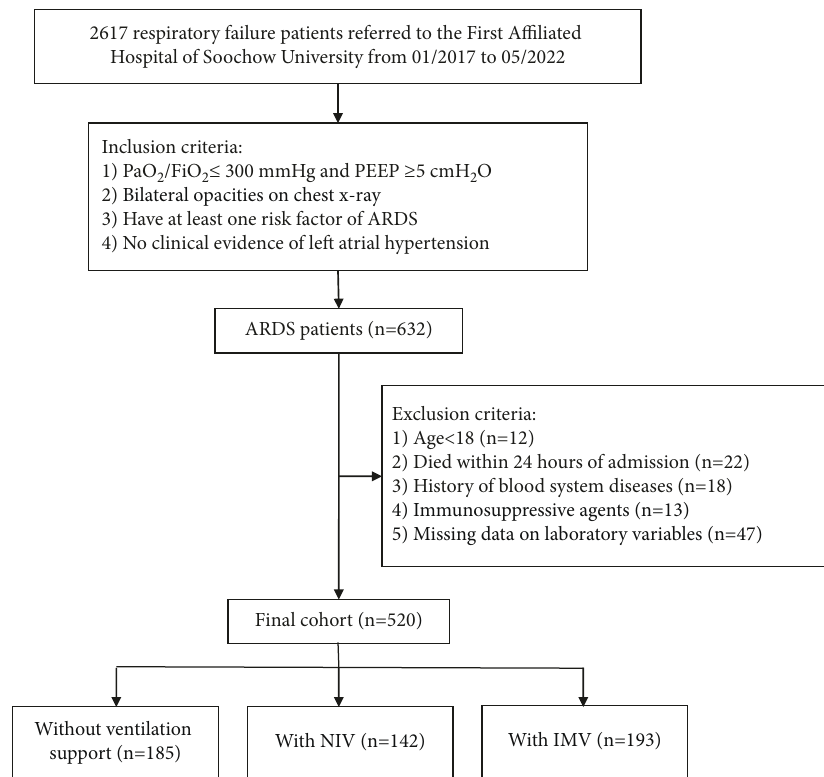
Figure 1: Research flowchart. ARDS, acute respiratory distress syndrome; NIV, noninvasive ventilation; IMV, invasive mechanical